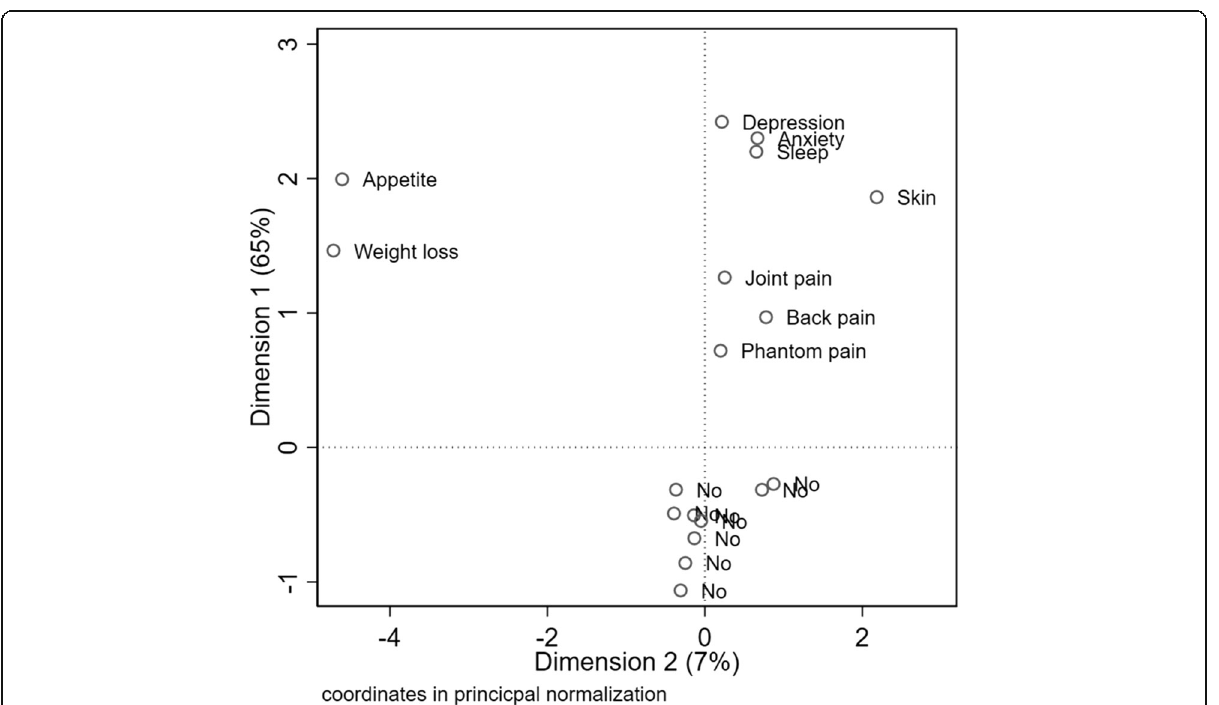
Fig. 4 Relationships between long-term complications and frequencies ( N = 254). * N = 254. The alluvial flow diagram shows how the general category (lower limb and upper limb left side) contains parts of finer classification, moving towards the right. The bold vertical lines indicate relative frequency. The colour code shows how each category moves into sub-categories, but change colour in the next